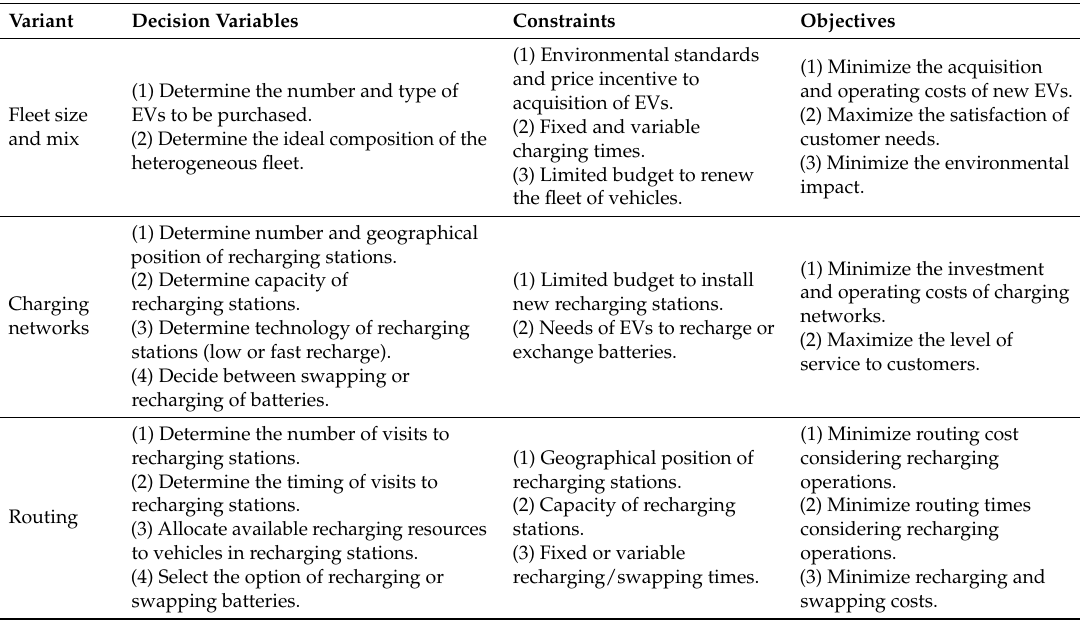
Table 2. Details of some new VRP variants related to